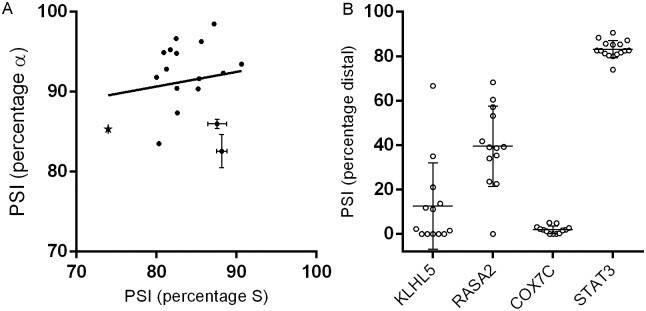
Analysis of “BodyMap” data.
(A)
STAT3 PSI (percentage spliced in) values for at α/(α+β) vs S/(ΔS+S); with white blood cells denoted with a star. Our data based on qPCR are plotted with SEM. (B) Scatter Plot of PSI for 4 genes with GTAGTT donor splice sites. Data as mapped from Illumina BodyMap data across 16 tissues; within a minimum read count value of 15. Means and standard deviations are shown.